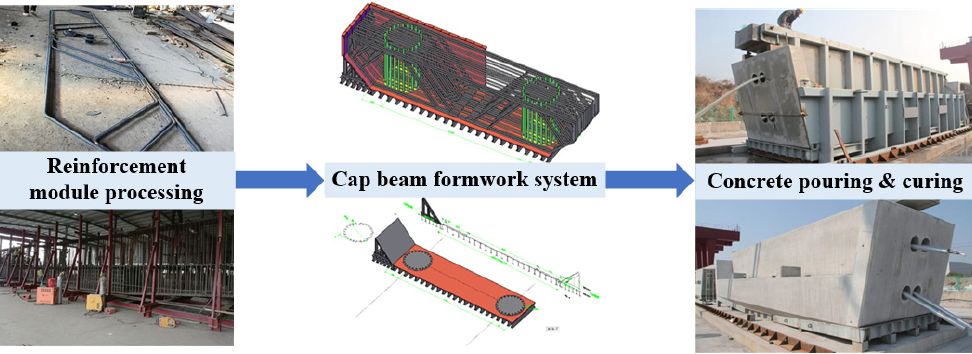
Figure 6. The prefabrication process of cap beam.